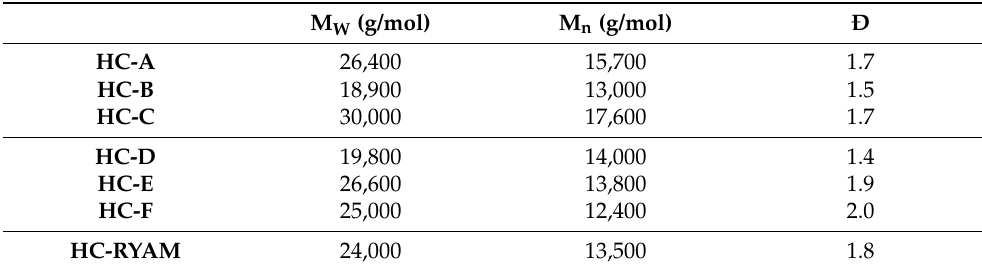
Table 4. Weight-average (Mw) and number-average (M n ) molar masses and dispersity (Ð = M w /M n ) of the hemicelluloses extracted from a sulfite